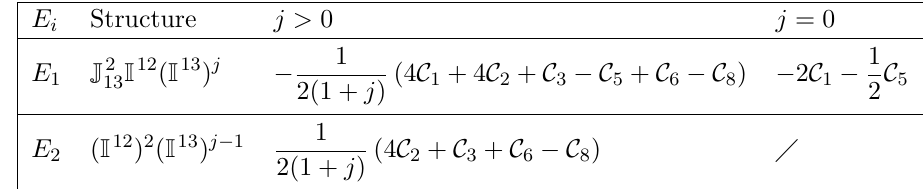
( QO ) SO when QO has h i = 0. C 6